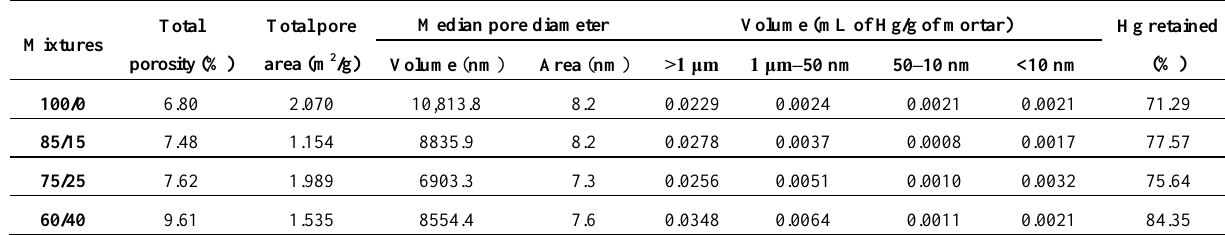
Table 5. MIP results for mortars cured after 270 days at 20 °C.